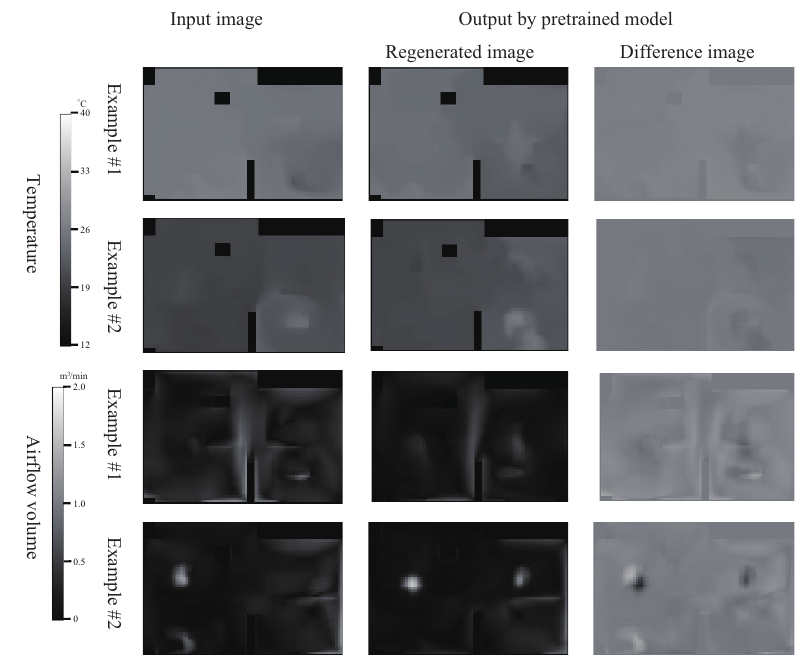
Figure 8. Examples of input, regenerated air-condition and difference in a large